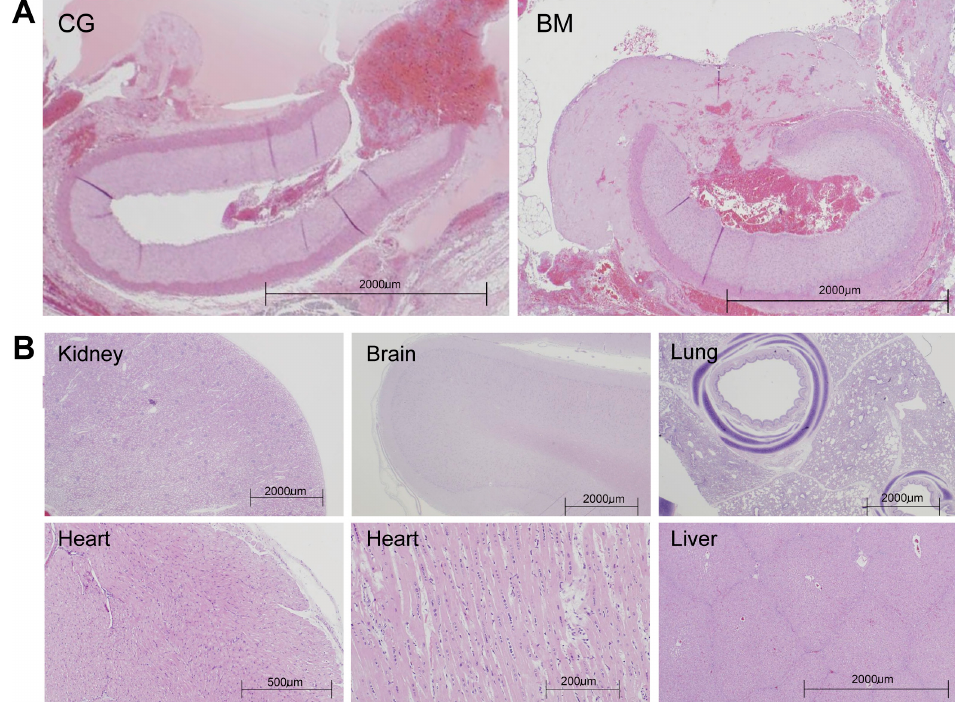
Figure 3. Histological assessment using hematoxylin and eosin (H&E) staining. ( A ) Low-power magnification of the arterial test segment demonstrating arteriotomy. The artery lumen contains clumping platelets bound by fibrin as well as red blood cells. A “seal membrane” was noted in the BM group; ( B ) Representative section of kidney, brain, lung, heart, and liver tissues.